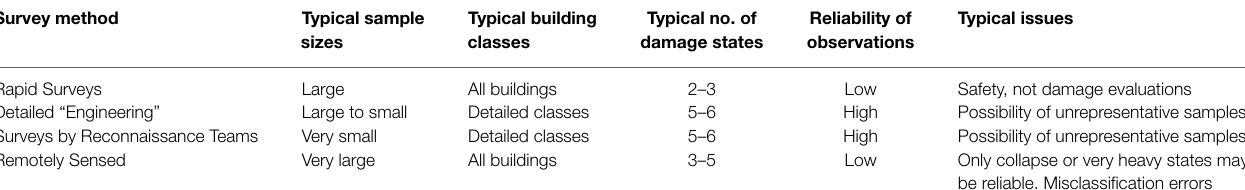
TABLE 6 | Database typologies and their main characteristics [adapted from Rossetto et al.